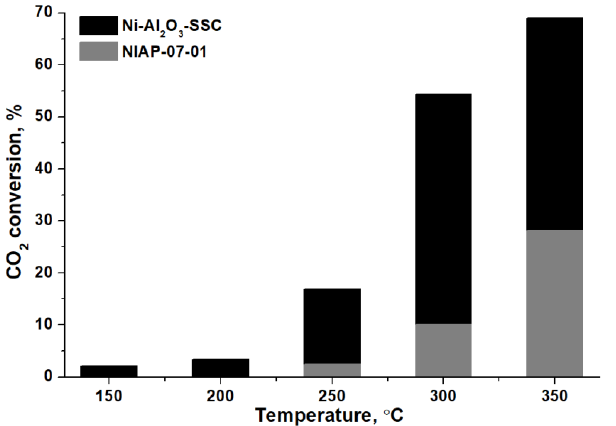
Figure 14. CO 2 conversion over Ni-Al 2 O 3 -SSC and NIAP-07-01 catalysts.